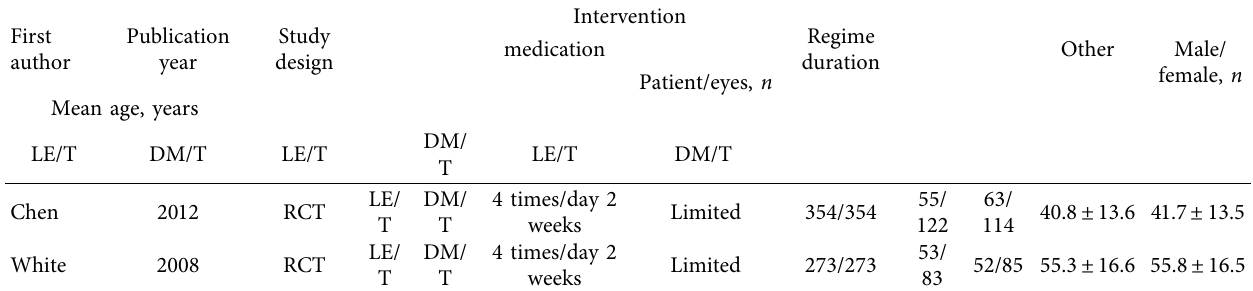
Table 1: Characteristics of the included studies.